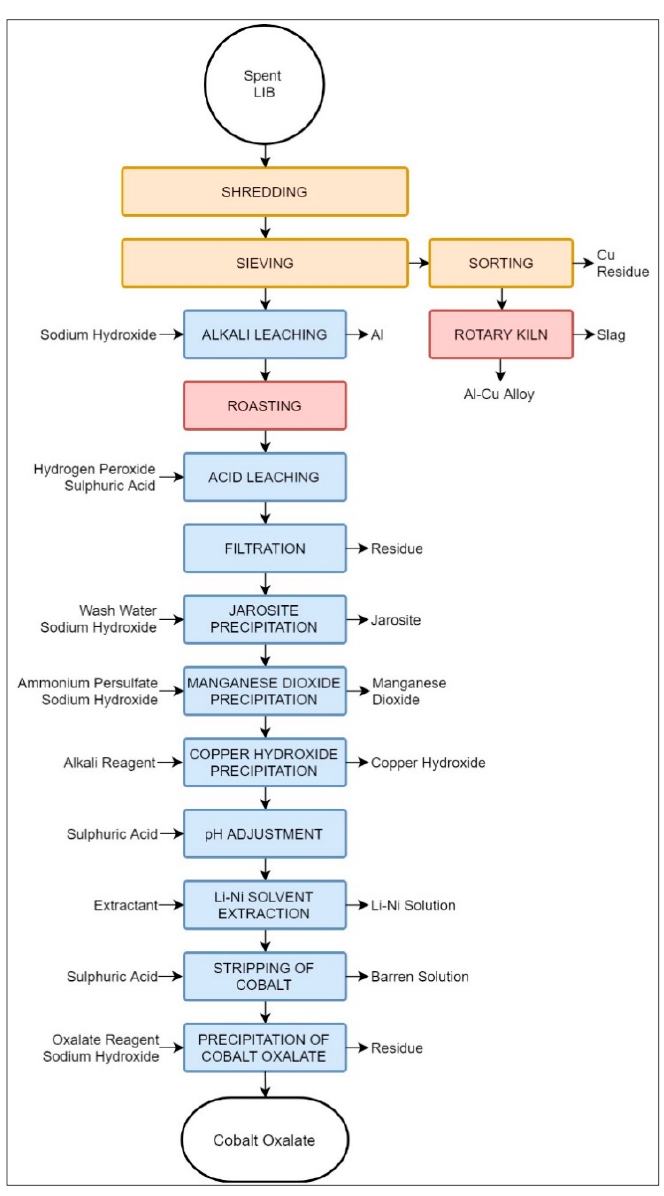
Figure 11. Schematic representation of Aalto University’s suggested recycling process.